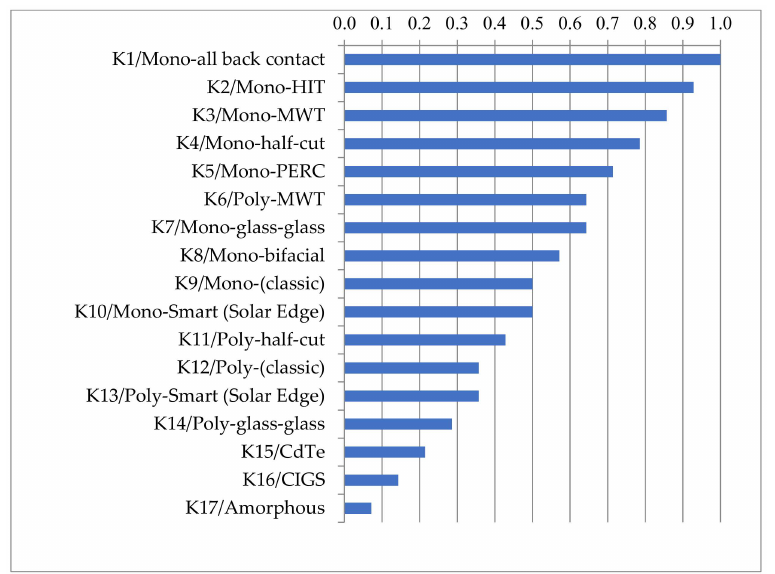
Figure 2. Visualization of the ranking of photovoltaic panel technology types based on “Option 1”